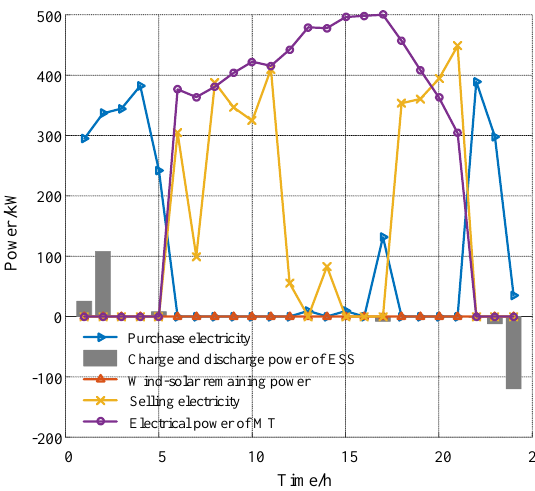
Figure 5. PIES optimal electrical power supply plan.